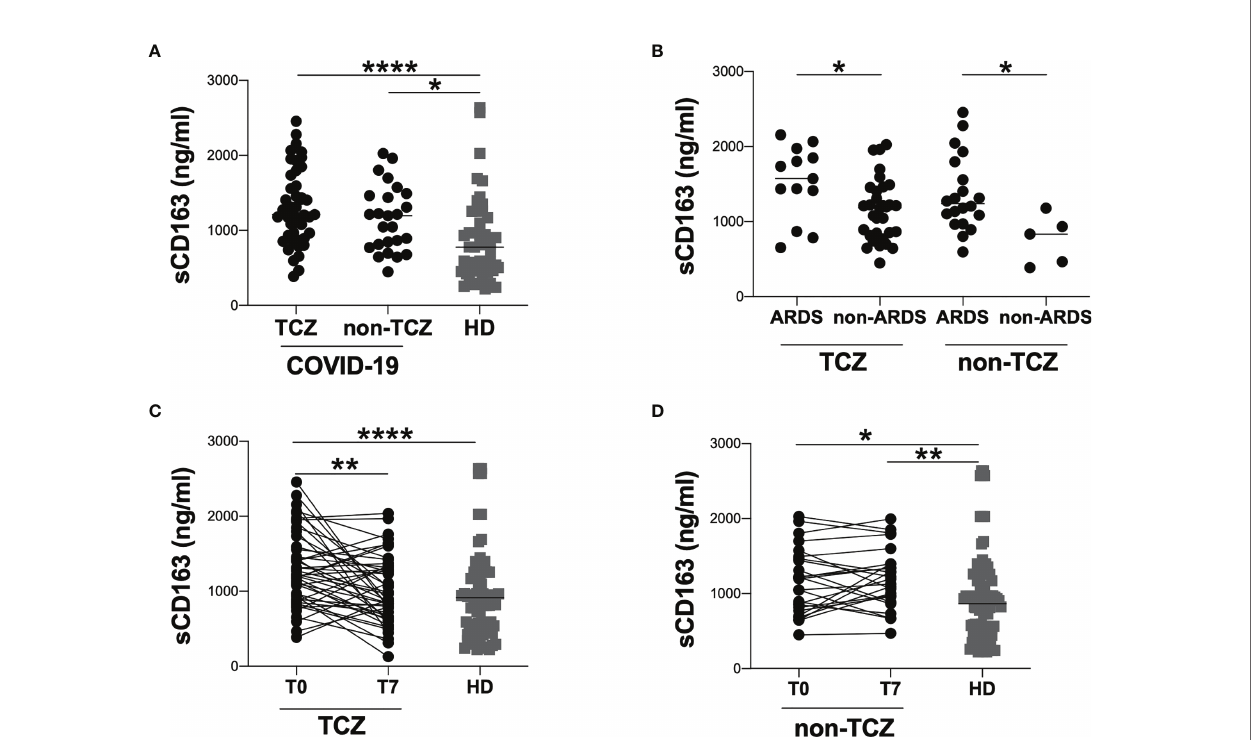
FIGURE 2 | Evaluation of sCD163 plasmatic levels in tocilizumab and non-tocilizumab groups. (A) sCD163 plasmatic levels were evaluated in 45 tocilizumab treated patients (TCZ) and 25 tocilizumab untreated patients (non-TCZ). The differences were evaluated using the nonparametric Mann-Whitney test. Data are shown as median (lines). Both TCZ and non-TCZ groups were compared to HD using the nonparametric Kruskal-Wallis test with Dunn ’ s post-test. Data are shown as median (lines). (B) sCD163 plasmatic levels were evaluated in tocilizumab treated (TCZ) and tocilizumab untreated (non-TCZ) patients strati fi ed according to the development of ARDS. The differences were evaluated using the nonparametric Mann-Whitney test. Data are shown as median (lines). (C) sCD163 plasmatic levels were longitudinal evaluated in 45 tocilizumab treated patients at two time-points: at T0 (on hospital admission) and T7 (after seven days from hospital admission) using Wilcoxon test. Both T0 and T7 were compared to HD using the nonparametric Kruskal-Wallis test with Dunn ’ s post-test. Data are shown as median (lines). (D) sCD163 plasmatic levels were longitudinal evaluated in 25 tocilizumab treated patients at two time-points: at T0 (on hospital admission) and T7 (after seven days from hospital admission) using Wilcoxon test. Both T0 and T7 were compared to HD using the nonparametric Kruskal-Wallis test with Dunn ’ s post-test. Data are shown as median (lines). ****p > 0.0001; **0.01 < p < 0.001; *0.05 < p